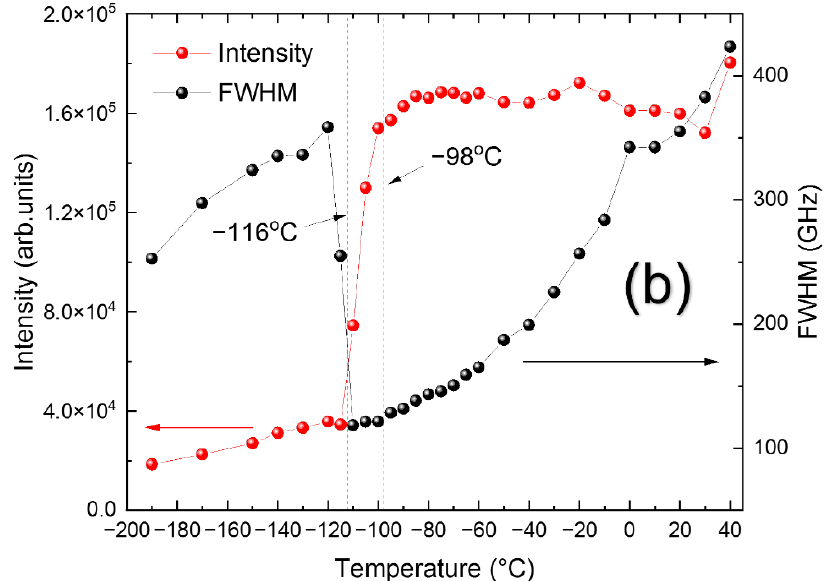
Figure 10. (Color online). ( a ) The central-peak spectra at several temperatures and ( b ) the temperature dependence of the central-peak intensity and its half-width.